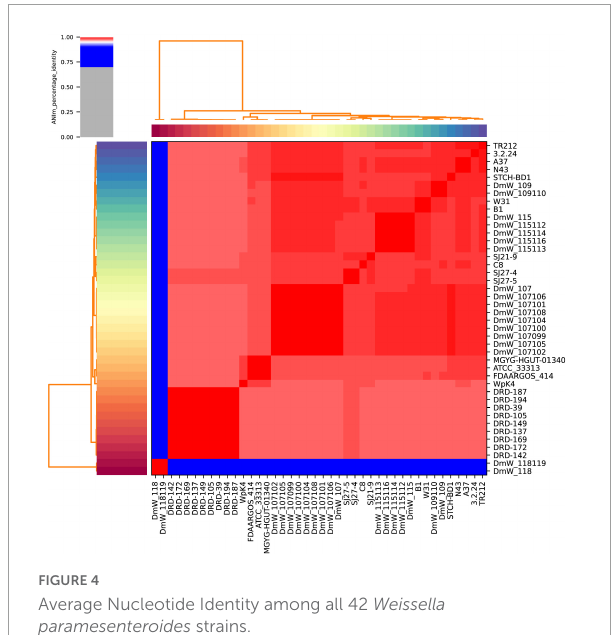
FIGURE4 Average Nucleotide Identity among all 42 Weissella paramesenteroides